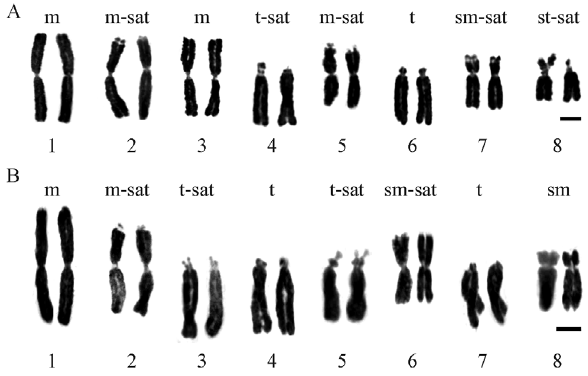
Figure 2 - Karyotypes of the Alstroemeria presliana populations (A) A. presliana subsp. presliana (populations 4192, 4362, 4364, 4365, 4372, and 4373); (B) A. presliana subsp. australis (populations 4250 C, 4369, 4370, 4371, and G. Fuentes s.n.). Scale bar = 5 (cid:3) m.